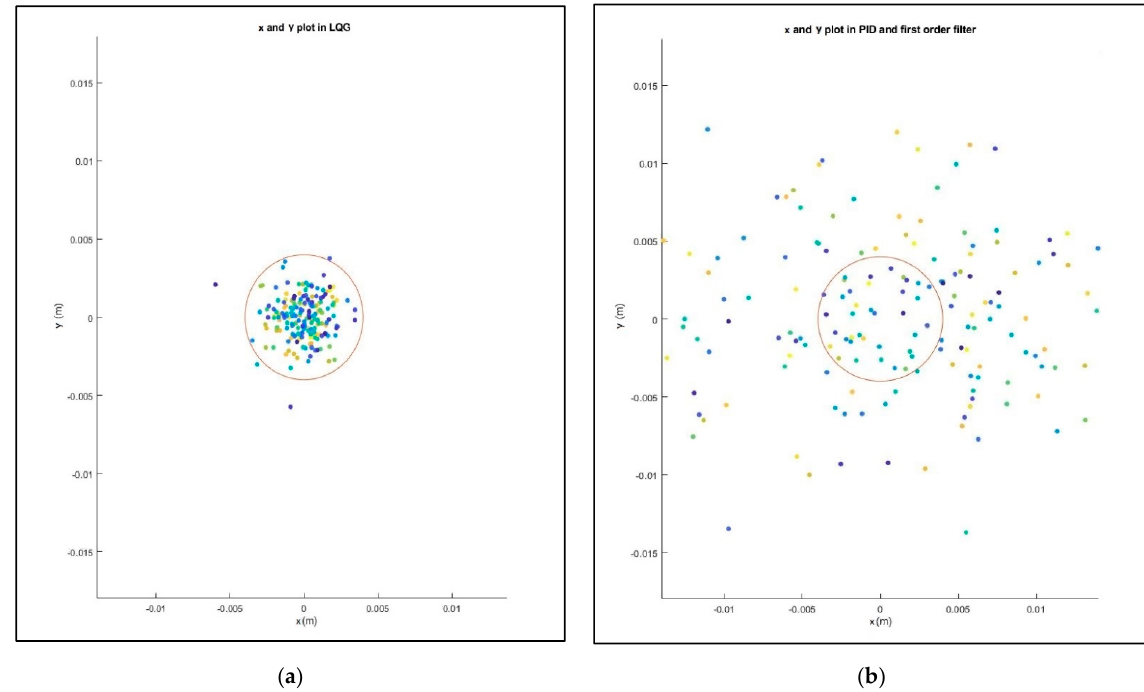
Figure 12. ( a ) System with LQG controller control result with waves. Monte Carlo study of 200 realizations. ( b ) System with classical controller control result with waves. Monte Carlo study of 200 realizations .